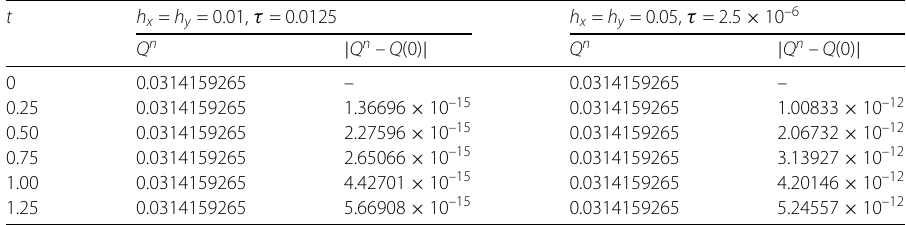
Table 7 Quantities Q n under different step sizes h x , h y , and τ at various